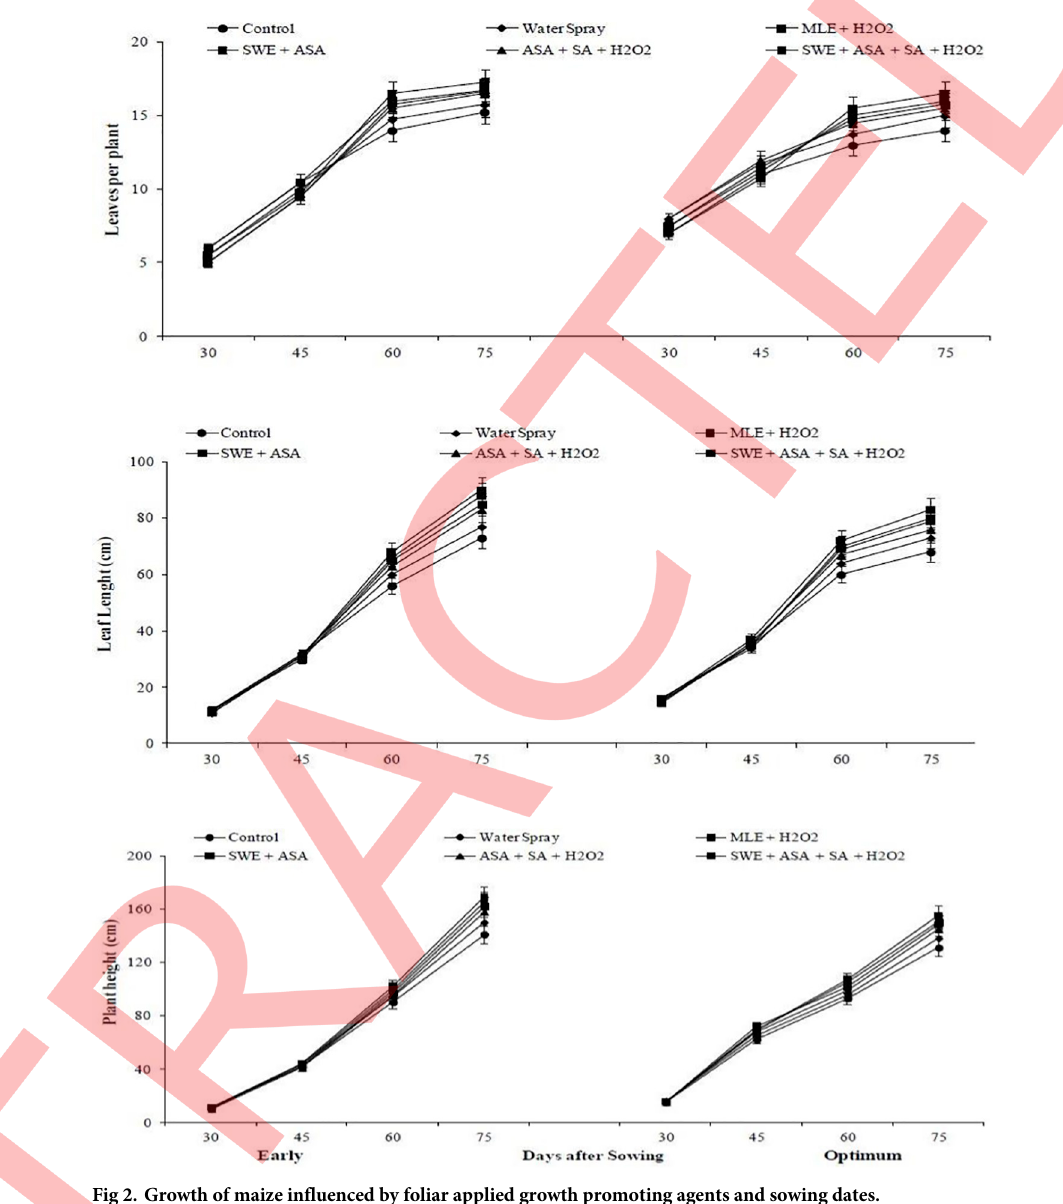
Fig 2. Growth of maize influenced by foliar applied growth promoting agents and sowing dates.